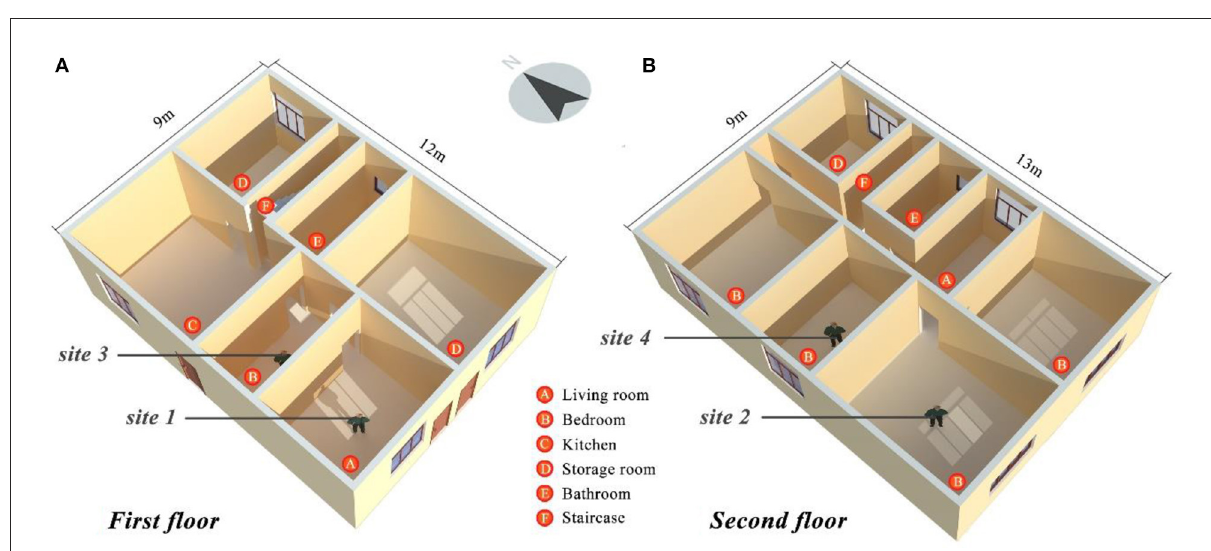
FIGURE4 The layout of rural dwellings and the location of the measurement sites (A) First Floor, (B) Second